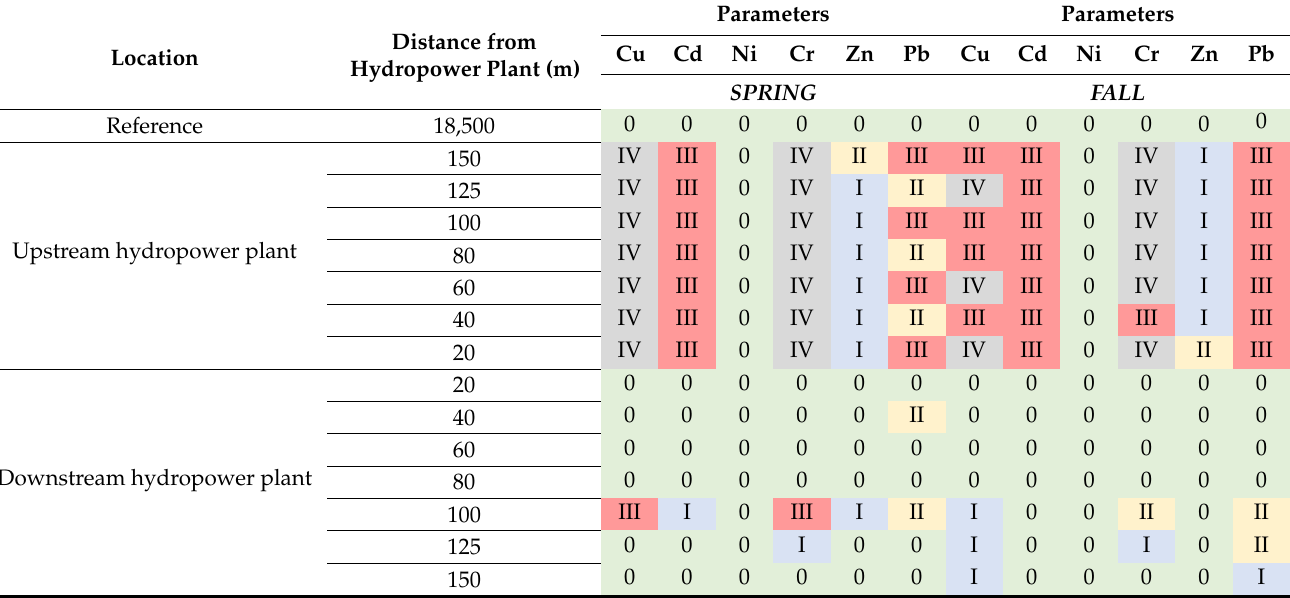
Table 6. Classification of sediment contamination with heavy metals according to the LAWA method.